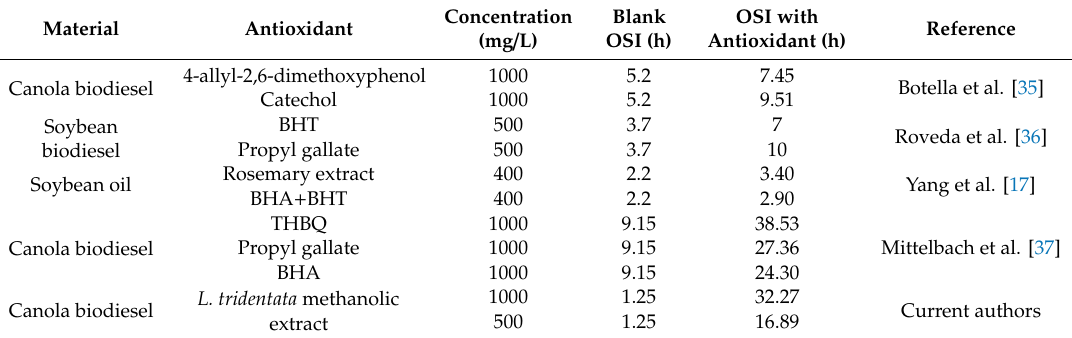
Table 6. Comparison between di ff erent antioxidants for oils and